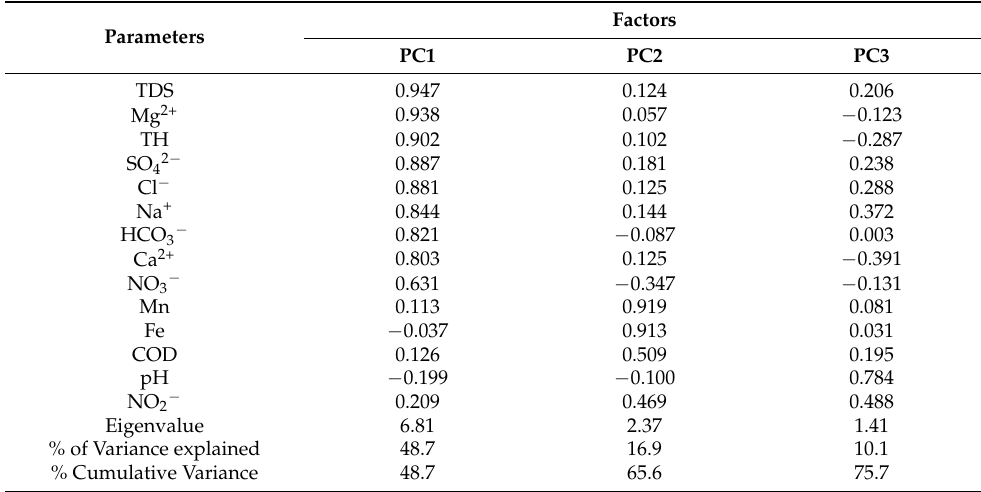
Table 5. Rotated component matrix of PCA on datasets of hydrochemical parameters in the Huang- shui River